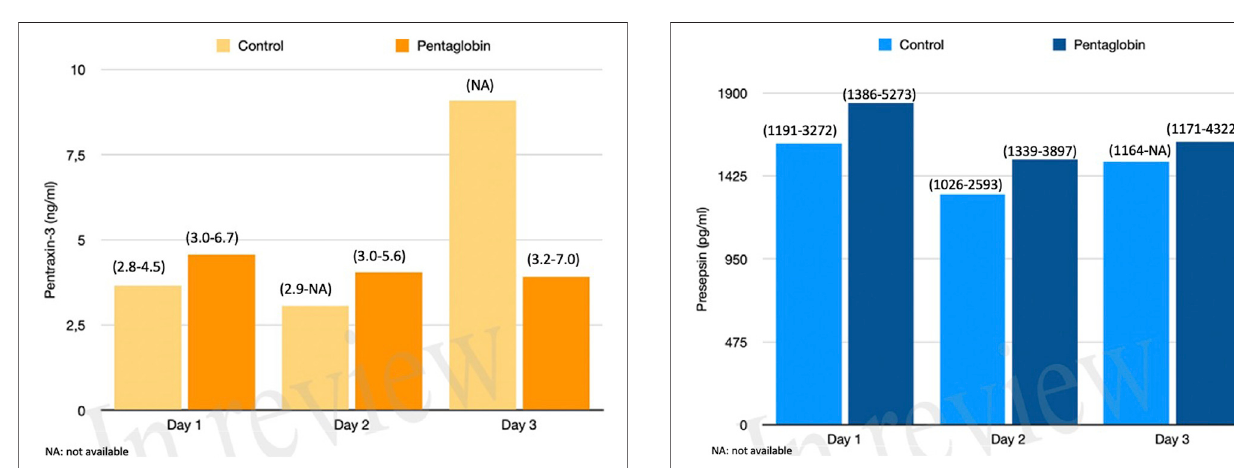
FIGURE 3 | Comparison of Pentraxin-3 changes over time between Pentaglobin and control groups by linear mixed models ( p (cid:1) 0.96). The height of bars represents the median values and the numbers in brackets the corresponding interquartile range of Pentraxin-3 levels between Pentaglobin treated patients and controls during the fi rst 3 days of ICU stay fromsepsisdiagnosis.PXT-3levelsincreaseddailyuptothethirddayinseptic patients treated with standard therapy (i.e., the control group) in agreement with the role of this acute-phase protein in the early phase of sepsis. The between-groups comparison over time was performed by linear mixed models and resulted to be not signi fi cant ( p (cid:1) 0.96). See text for more details.